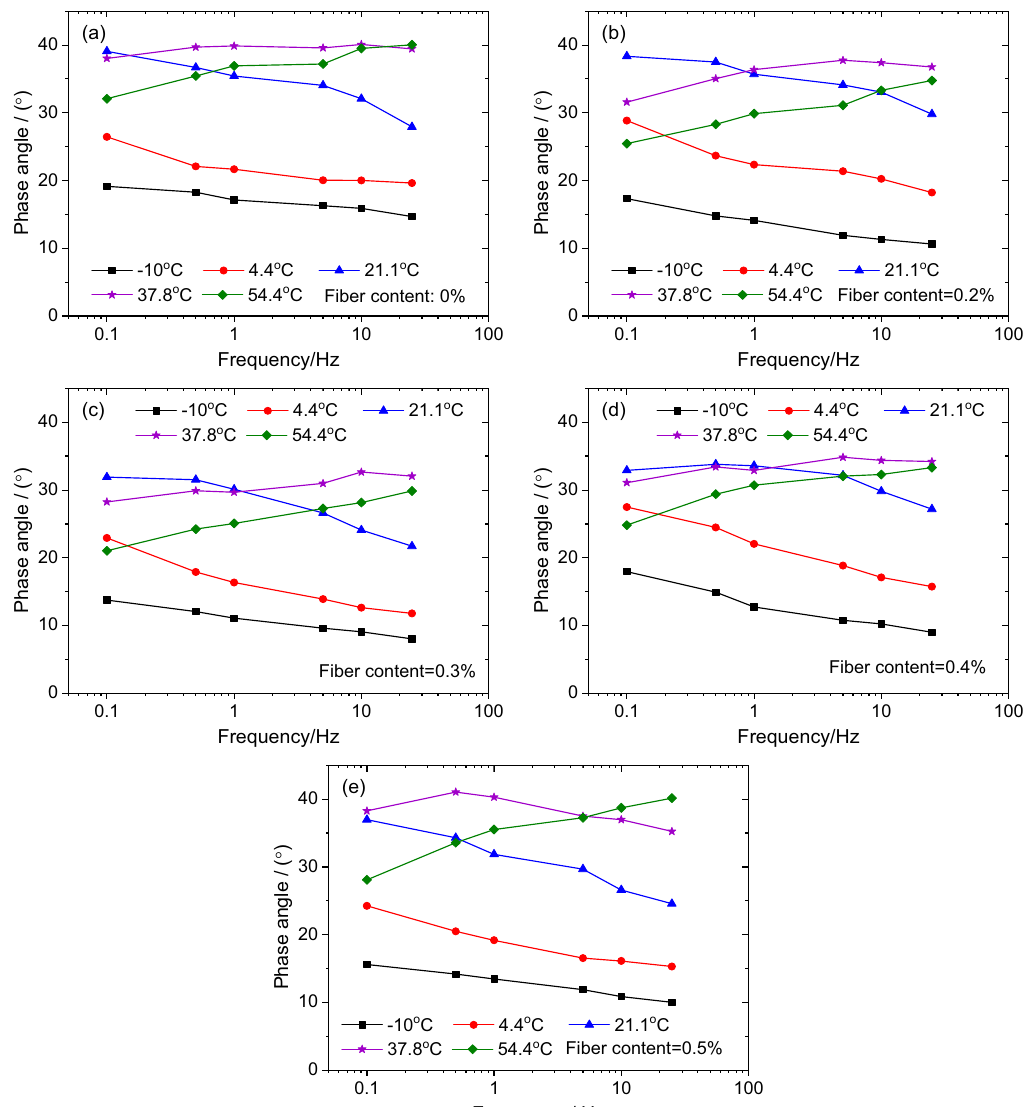
Figure 5: Variation of phase angles with frequencies at various temperatures for SBS - modi fi ed AC mixtures with basalt fi bers: ( a ) 0% fi ber, ( b ) 0.2% fi ber, ( c ) 0.3% fi ber, ( d ) 0.4% fi ber, and ( e ) 0.5% fi